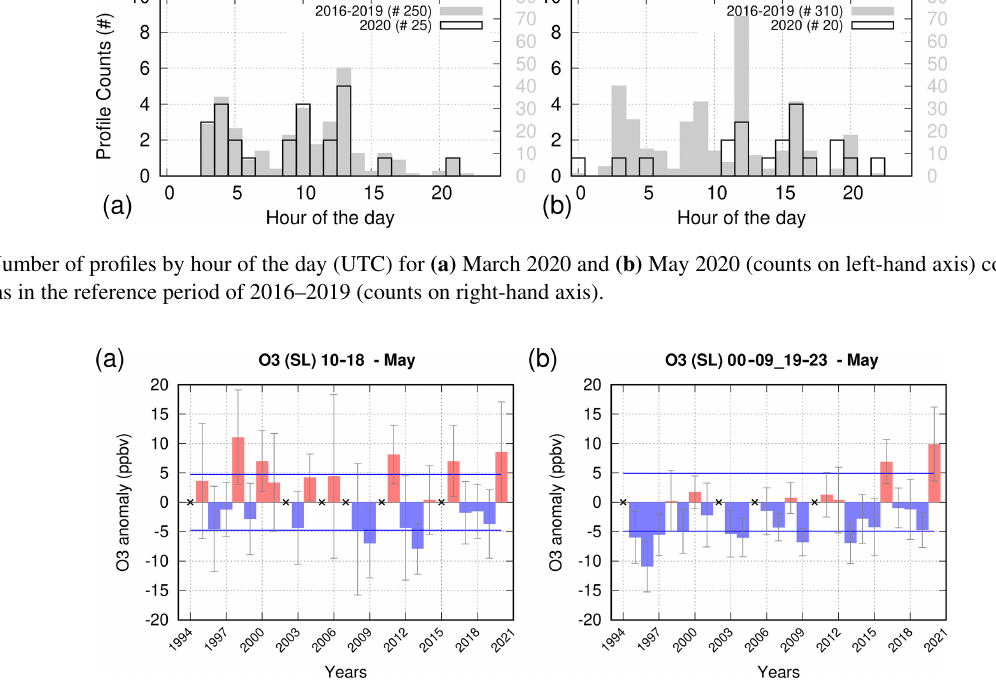
Figure 5. Anomalies of ozone for 1994–2020 for the month of May in the surface layer ( > 950hPa) for the (a) daytime (10:00–18:59UTC) and (b) nighttime (00:00–09:59 and 19:00–23:59UTC). The grey bars represent the 95% confidence limits, and the blue horizonal lines represent the interannual